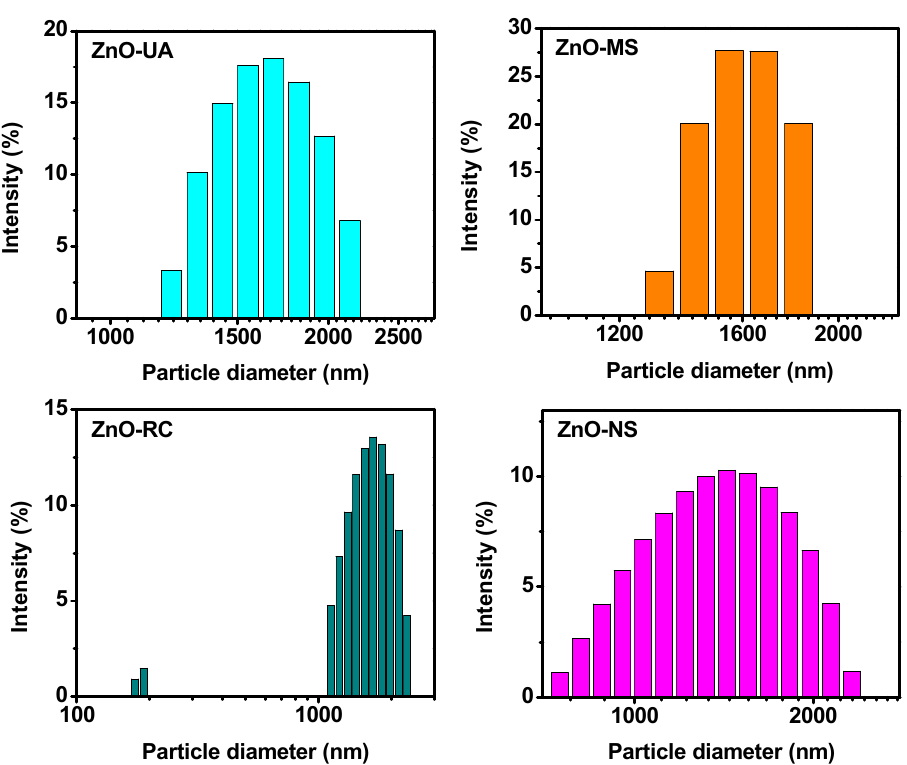
Figure 3. Size distribution of ZnO NPs from dynamic light scattering (DLS).